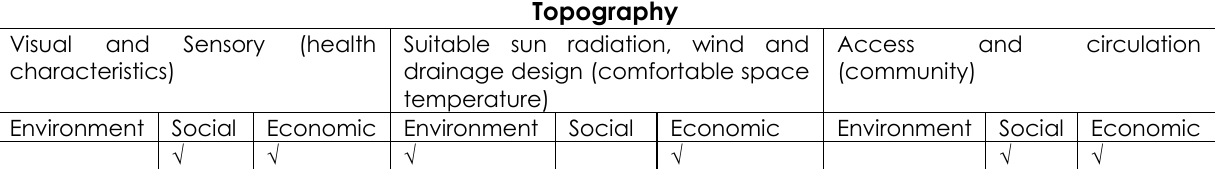
Table 2. Integration between Topography Characteristics and Dimension of